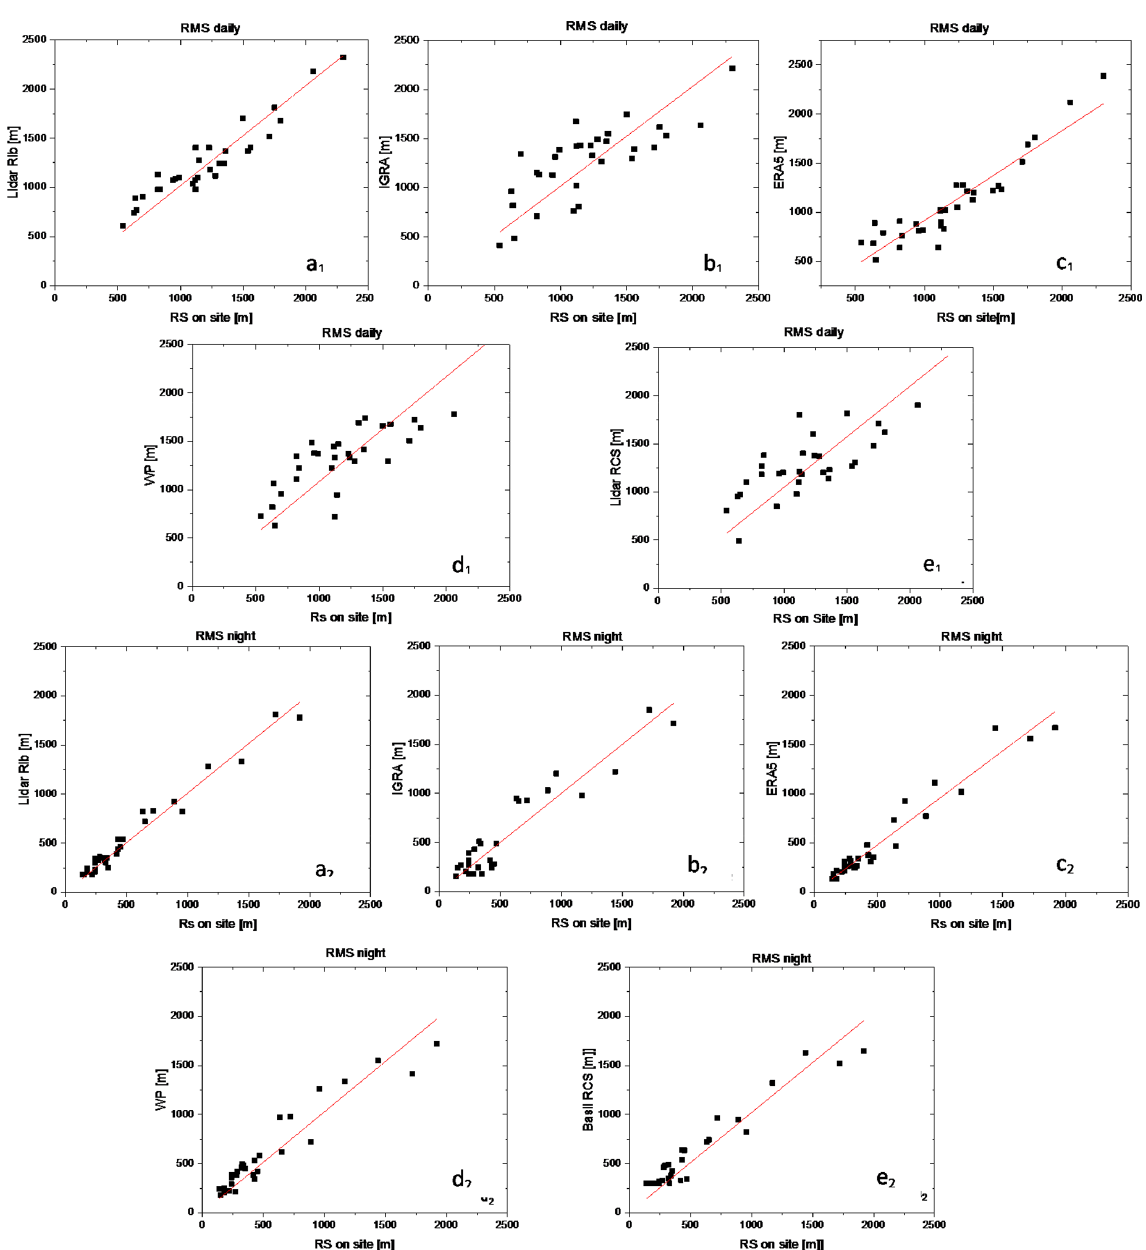
Figure 3. Comparison of the different ABLH estimates expressed in terms of scatter plots. On the x axes of each plot are the ABLH reference values obtained through the application of the Richardson number approach to the on-site radiosonde profiles, while on the y axes are the values from the five remaining ABLH estimates. Panels (a) – (e) represent daytime comparisons and panels (f) – (j) night-time comparisons. Panels (a1) and (a2) : “Lidar Ri b ” vs. “RS on-site”; panels (b1) and (b2) : “IGRA” vs. “RS on-site”; panels (c1) and (c2) : “ERA5” vs. “RS on-site”; panels (d1) and (d2) “WP” vs. “RS on-site”; panels (e1) and (e2) : “Lidar RCS” vs. “RS on-site”. The red lines represent the linear fit applied to the data points using a linear regression function with the form Y = A × X